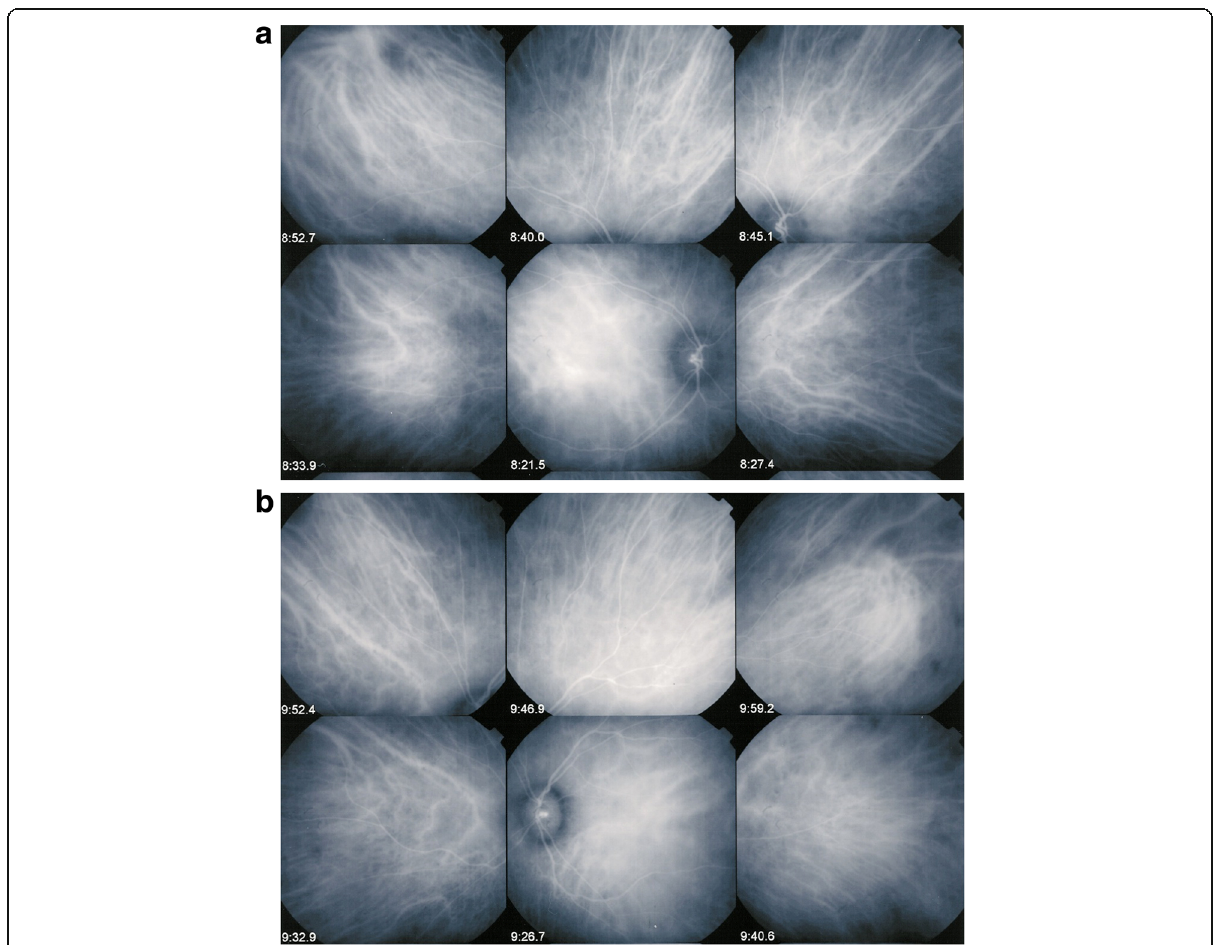
Fig. 4 Fundi of VKH case 2 months after dual steroidal and non-steroidal immunosuppression. The left fundus shows again a normal colour